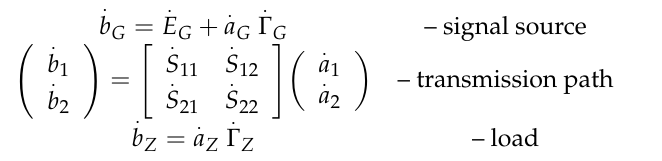
four-terminal network of a microwave transmission path.